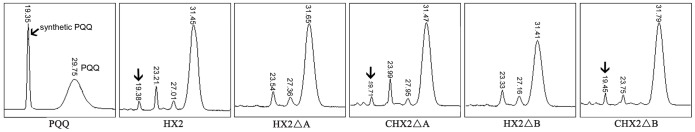
RP-HPLC detection of PQQ synthesized by R. aquatilis HX2 and derivative strains.Arrows indicate 5-acetonyl-PQQ.